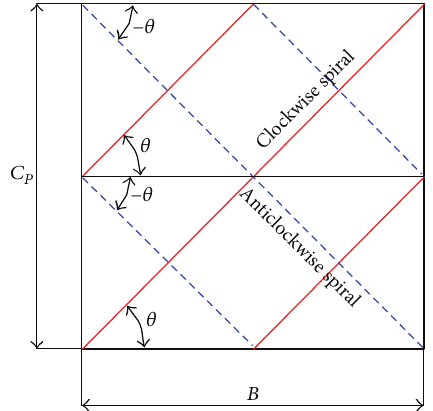
Figure 3: Schematic of unfolded pipe wall